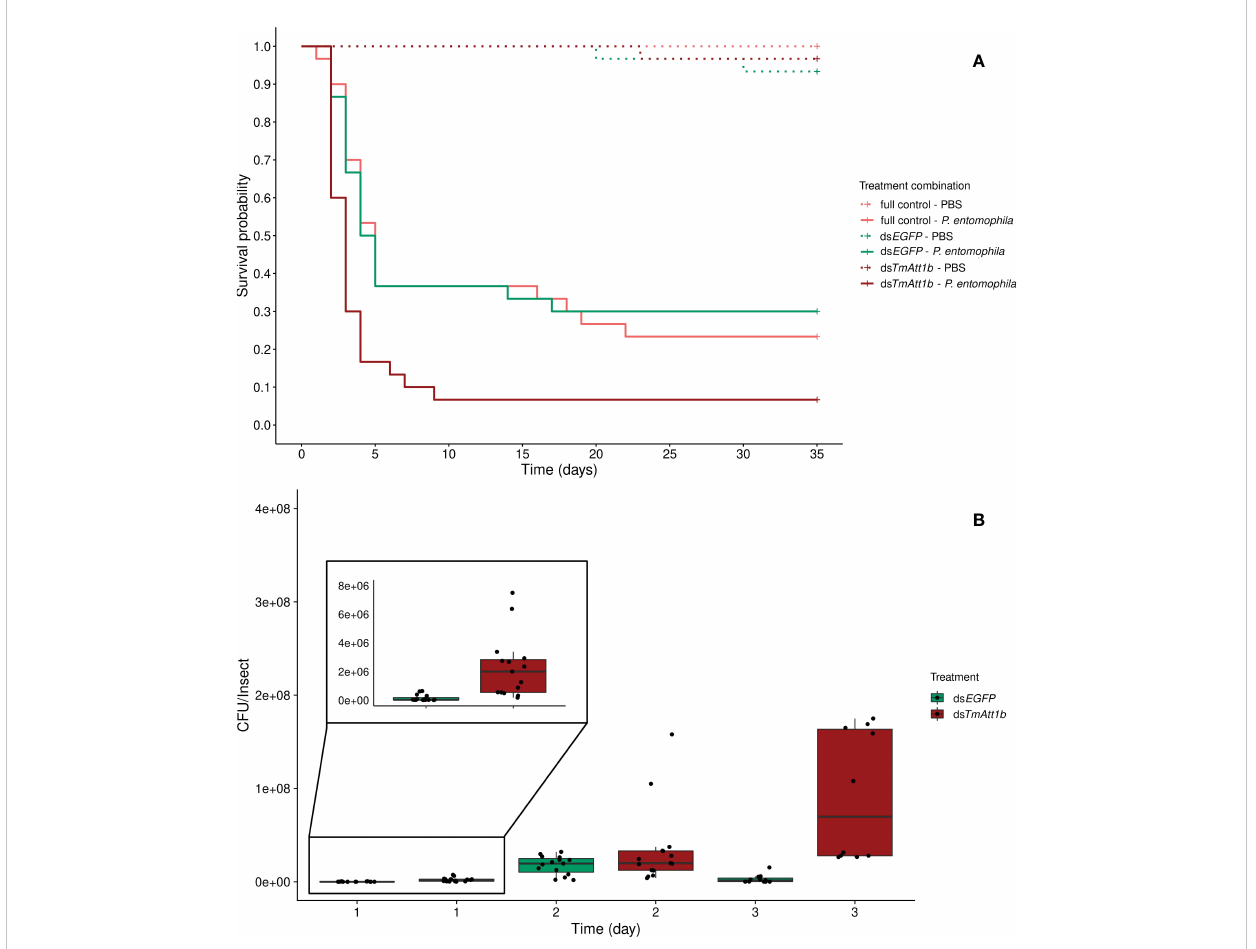
FIGURE 2 (A) Effect of TmAttacin1b ( TmAtt1b ) knockdown on survival of Pseudomonas entomophila infected Tenebrio molitor females over 35 days. ds